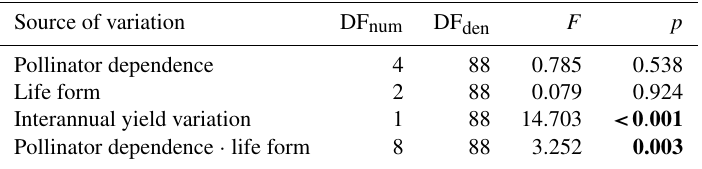
Table A5. Analysis of variance of a PGLS fitted model constructed to assess whether the slowdown in mean yield growth found in tree crops could be explained by Jensen’s inequality effect. Interannual yield variation was used as a proxy reflecting the effect of variable pollen delivery (i.e., a resource needed for seeds or fruit production) on yield